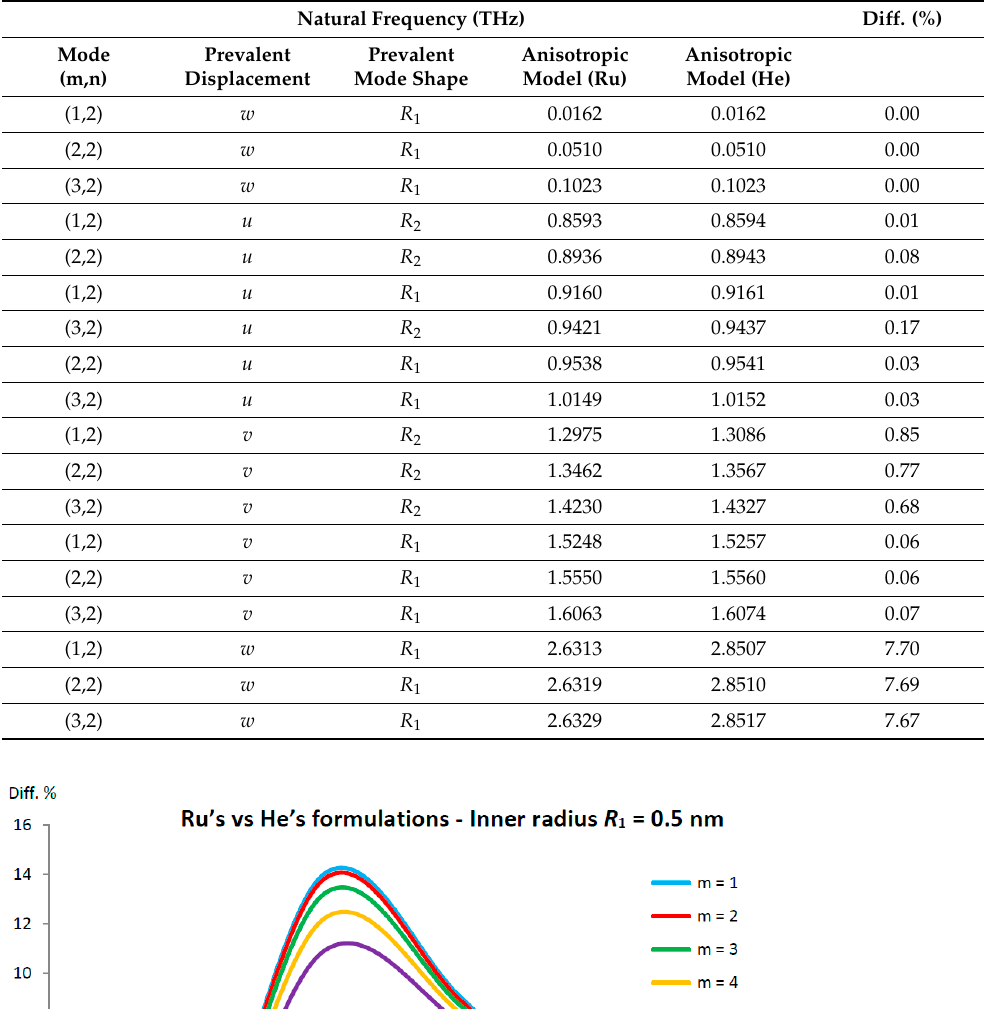
Table 5. Natural frequencies (THz) of the simply supported DWCNT of Table 1 with inner radius R 1 = 5 nm and aspect ratio L / R 2 = 10. Donnell shell theory. Anisotropic elastic shell model. Circum- ferential flexure modes ( n = 2). Van der Waals interaction forces. Comparisons between Ru’s (38) and He’s (39) formulations.